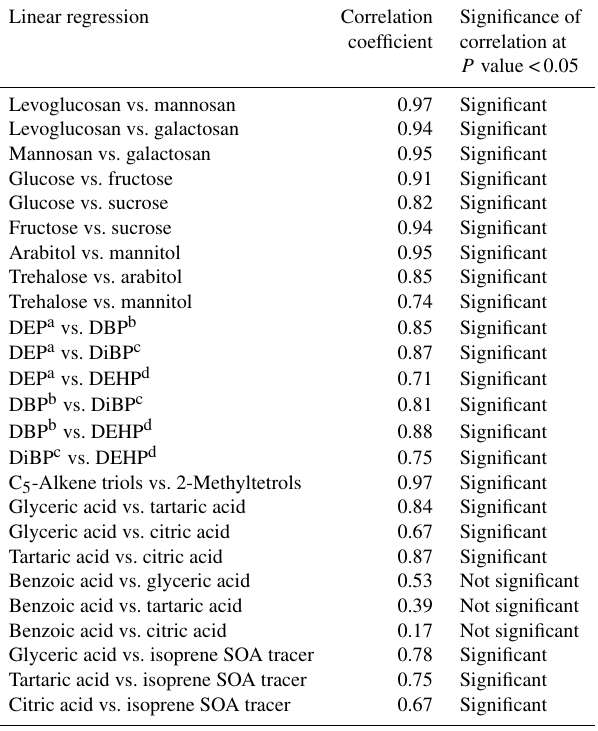
Table 2. Statistical summary of correlations among the organic trac- ers in PM 2 . 5 aerosols from central